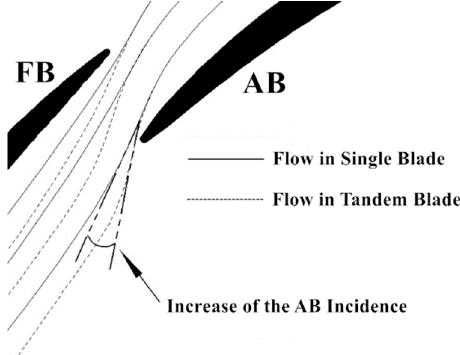
Figure 8. “Nozzle effect” in the tandem blade. Figure 8. “Nozzle e ff ect” in the tandem